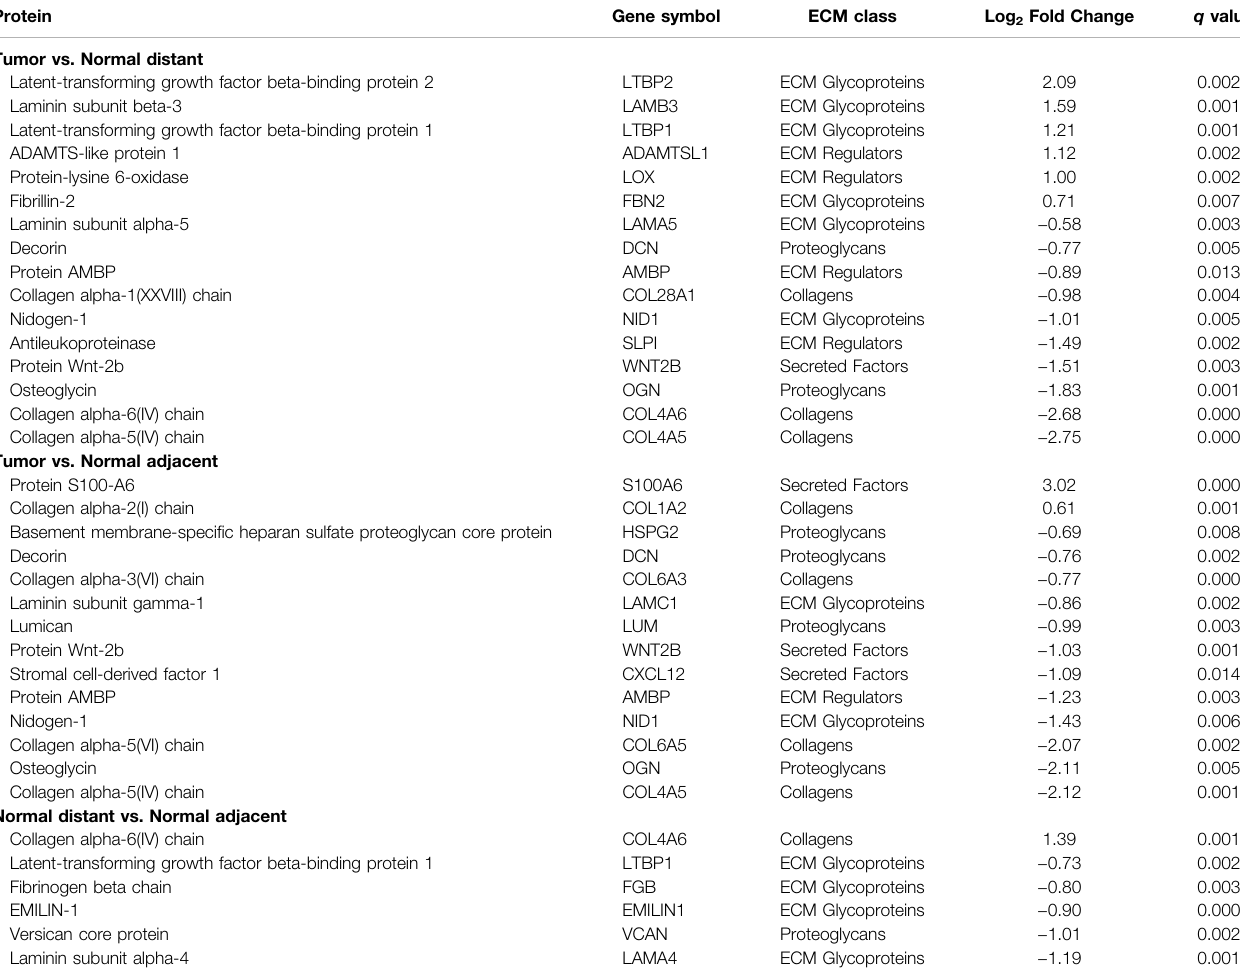
TABLE 1 | Differentially expressed proteins among tumor, normal distant and normal adjacent tissues.